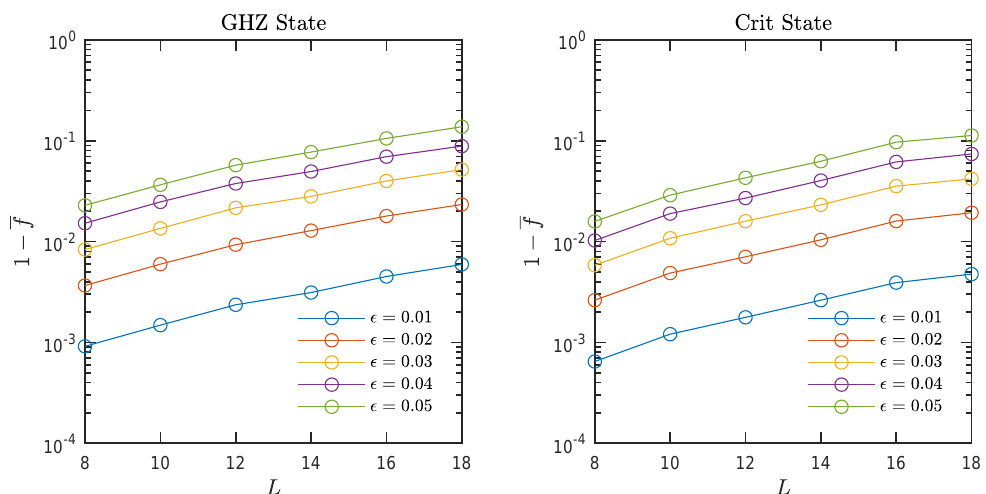
Figure 10: Effect of errors of strength ε on the VQCS preparation of GHZ and critical states for system size L . Plotted is the infidelity averaged over 1000 error realizations (denoted by the